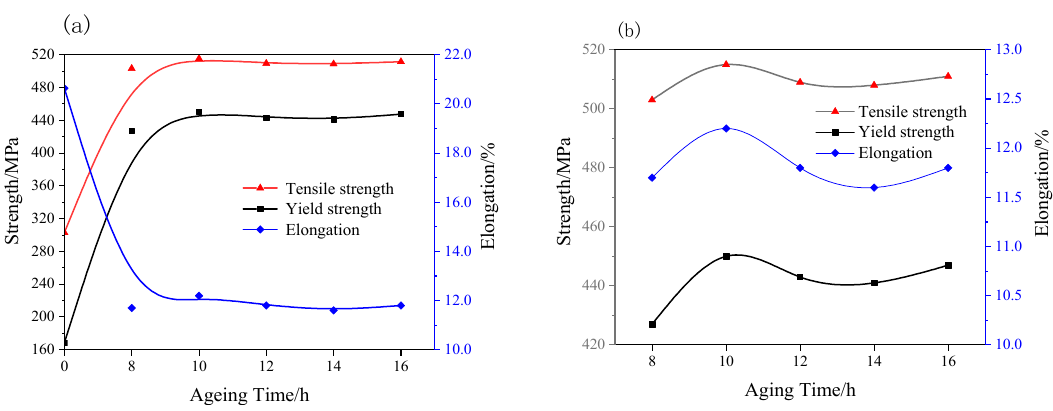
Figure 3. Tensile properties of the 7075 Al sheets subjected to different one-step aging treatments. ( a ) The tensile properties during the whole process and ( b ) a section of the process.